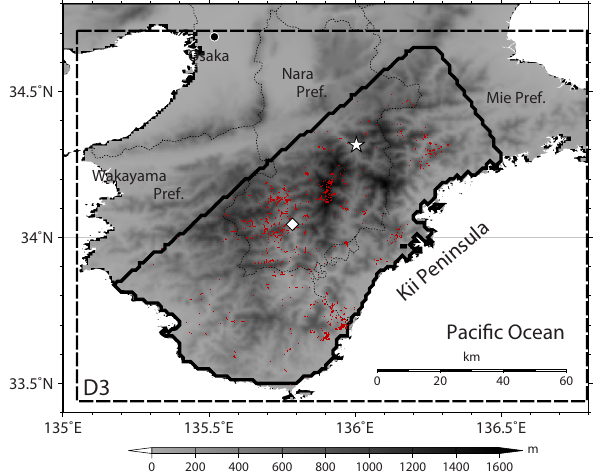
Figure 3. Location of the study area of the Kii Peninsula (solid line) and computational domain 3 of the present study (dashed line). The altitude is indicated by grayscale. The black dotted line indicates the prefectural boundary. The white star and diamond indicate the lo- cations of Kamikitayama and Kazeya stations (AMeDAS), respec- tively, operated by the JMA. The red dots indicate the locations of the analyzed landslides provided by